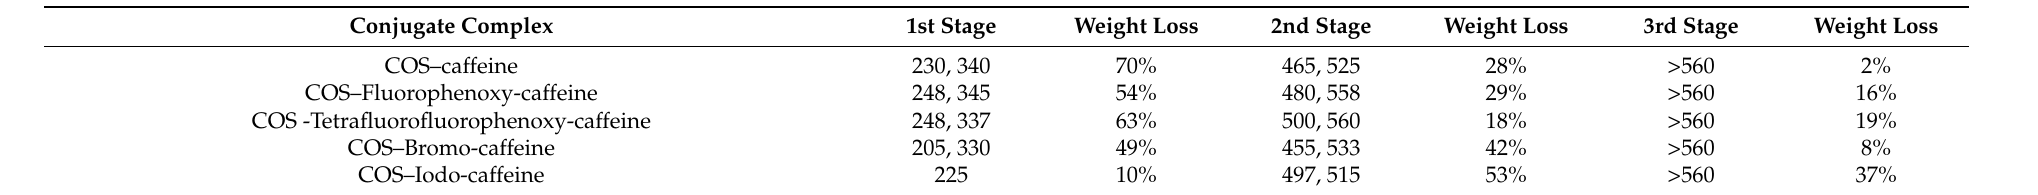
Table 3. Thermal effects ( ◦ C) and weight loss (%) along the degradation stages observed in the TG curves for the COS conjugates with caffeine and its